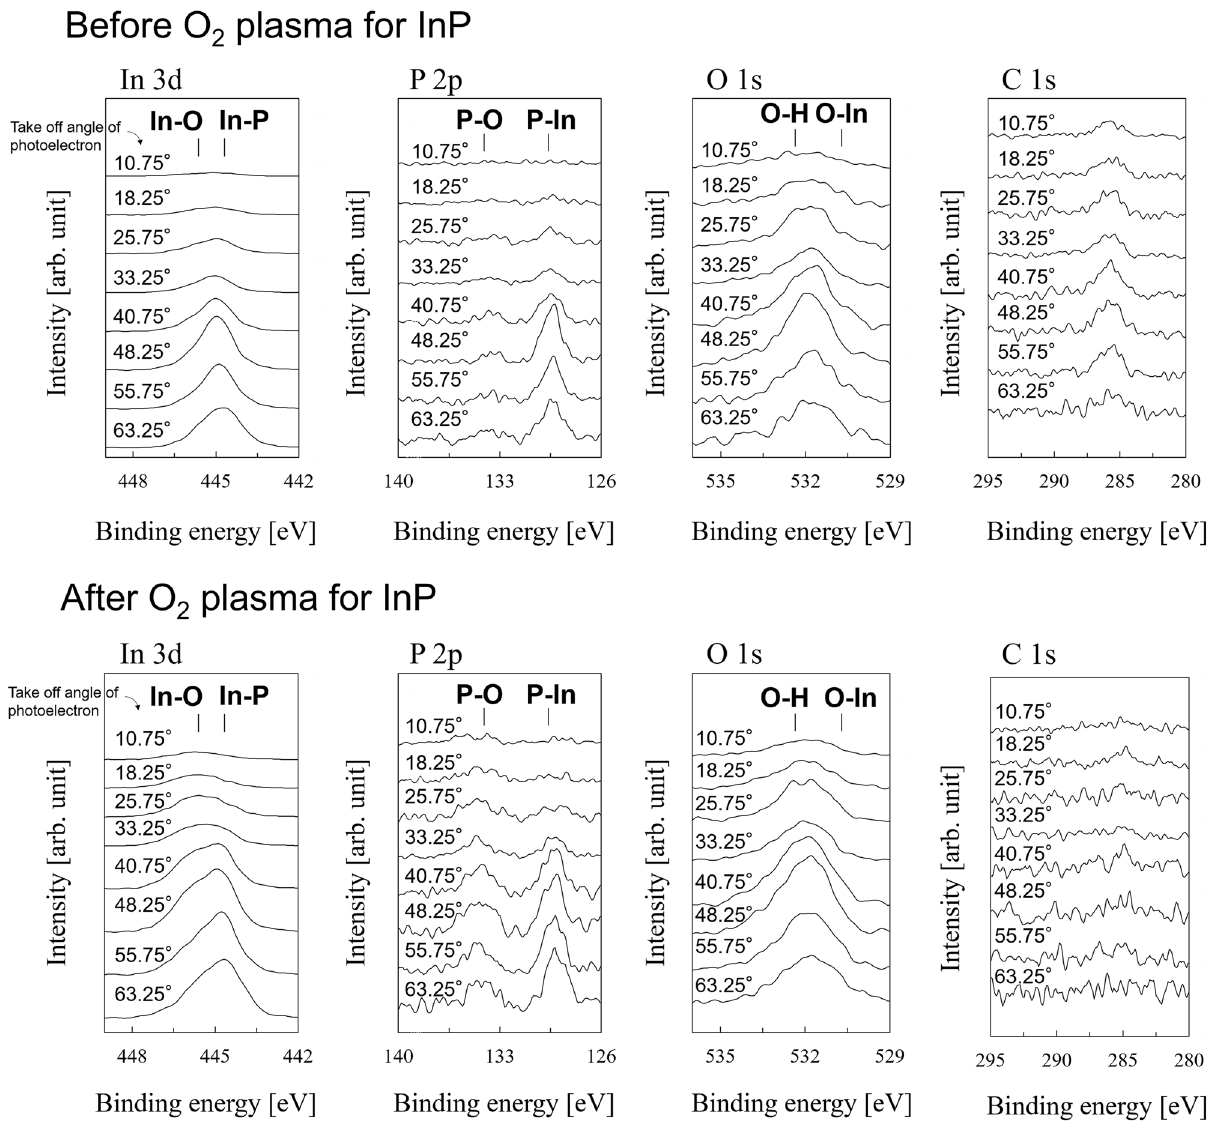
Figure 4. XPS spectra of InP substrate before and after oxygen plasma irradiation. The activated InP surface was functionalized with OH